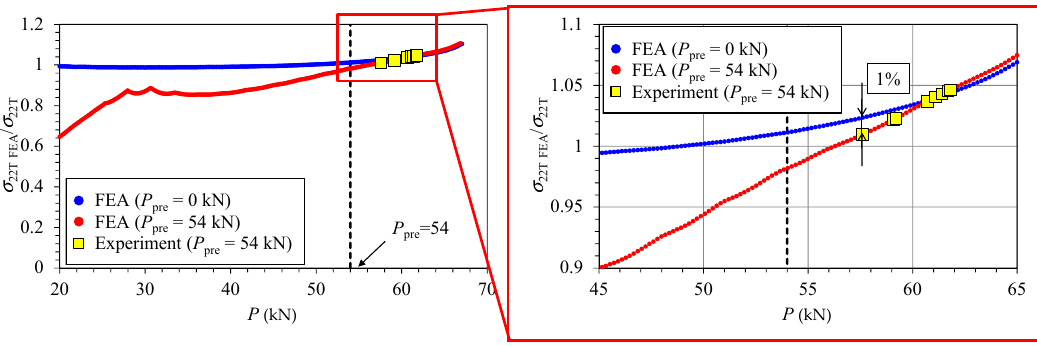
Figure 7. Comparison of relationship between normalized midplane crack-opening stress on x 1 -axis σ 22T FEA / σ 22T and load P without ( P pre = 0 kN) and with ( P pre = 54 kN) CRS for HT780. When the difference in σ 22T FEA / σ 22T between the two cases became smaller than 1%, fracture was observed for the case with CRS.